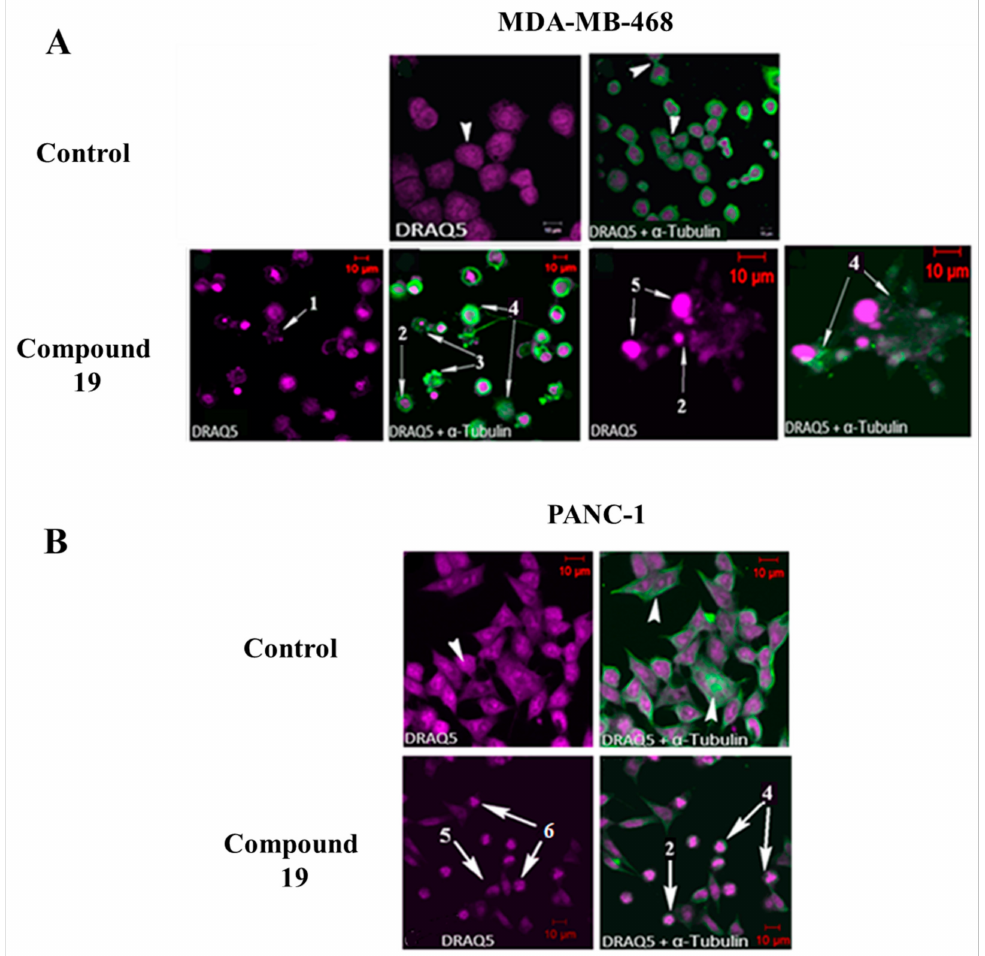
Figure 7. Effect of 19 on ( A ) MDA-MB-468 and ( B ) PANC-1 cells, after 24 h of exposure at GI 50 concentration. Compound 19 causes nuclear fragmentation (1), multinucleation (2), membrane blebbing (3), microtubule network disruption (4), membrane disruption of nuclei (5), lunate morphology of chromatin, and chromatin condensation (6). The experiments were repeated three times. Cells were immunostained with an antibody specific for α -tubulin (green) and counterstained with DRAQ5